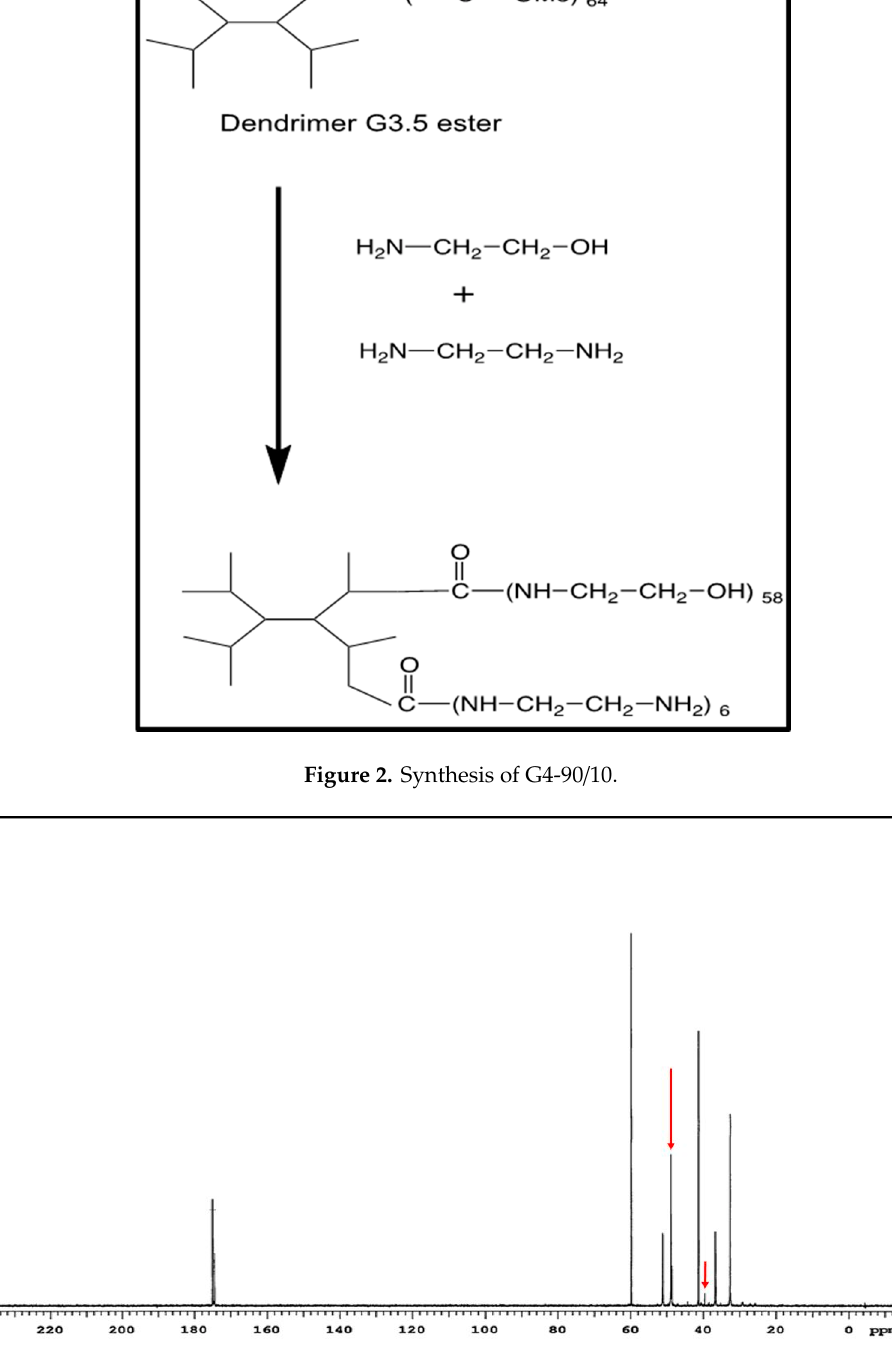
Figure 3. 13 C NMR spectrum of G4-90/10.